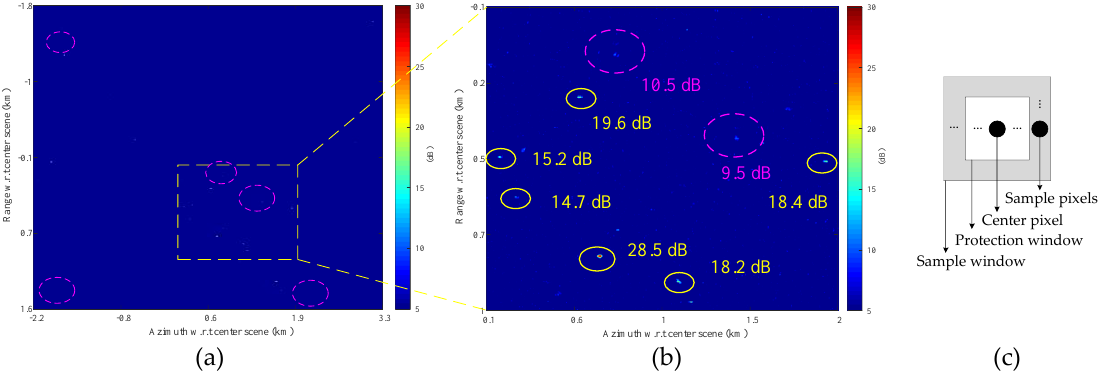
Figure 9. Clutter cancellation result in term of output SCNR (the clutter-plus-noise power is estimated for each pixel from adjacent pixels, which are selected by the sliding window of the constant false alarm rate (CFAR) detector): ( a ) full scene; ( b ) magnified part of ( a ); and ( c ) clutter-plus-noise power estimation.